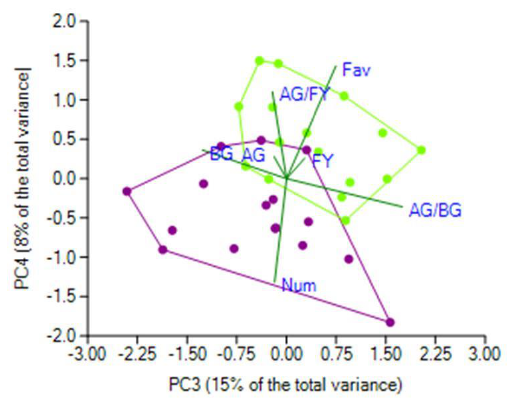
Figure 3. The location of husk tomato production characteristics (variables for analysis) and husk tomato cultivars in the plane of principle components 3 and 4. Abbreviations used for plant variables: AG, aboveground biomass; BG, belowground biomass; Num, the number of fruits; FY, fruit yield (mass); Fav, average mass per fruit; AG/FY, the ratio of the aboveground biomass to fruit yield and belowground biomass; AG/BG, the ratio of the above- to the belowground biomass. Violet circles represent Plum Jam, and green circles represent Confectioner.